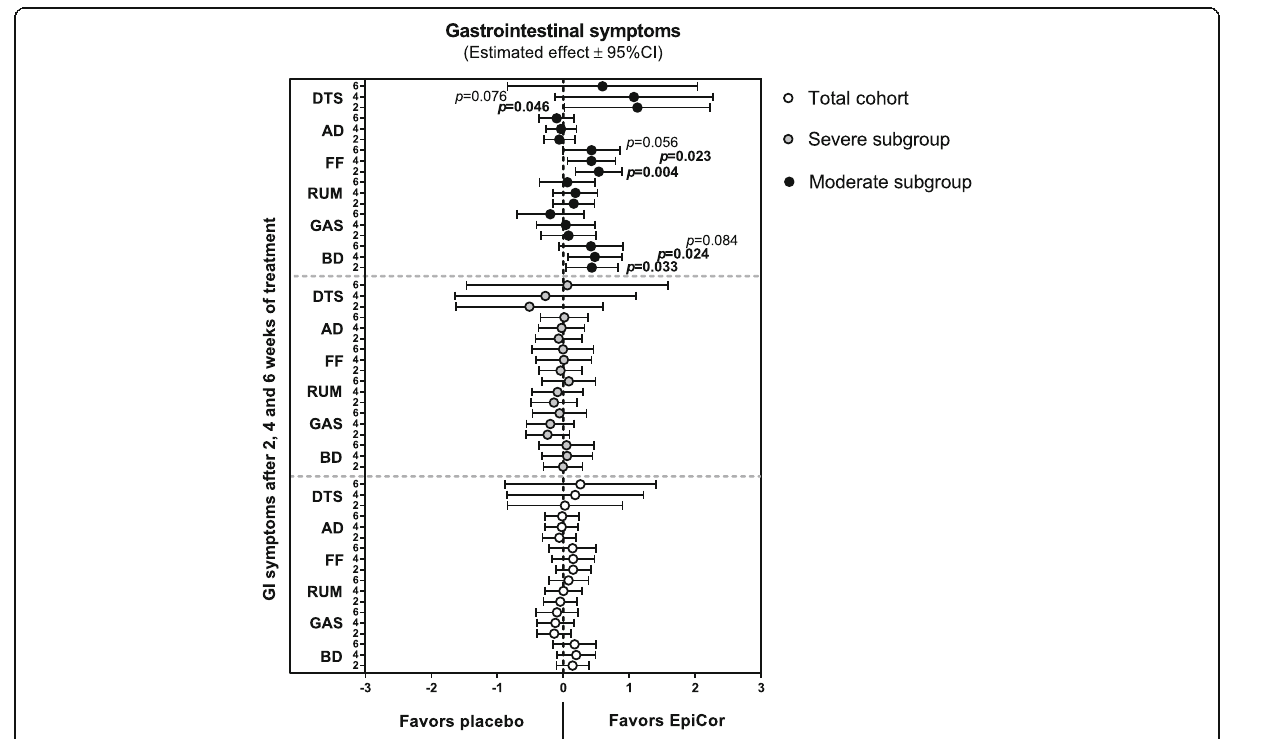
Fig. 3 Mean differences between EpiCor and placebo on gastrointestinal symptoms on the three cohorts. Legend: The enlisted gastrointestinal symptoms are BD (bloating/distension), GAS (passage of gas), RUM (GI rumbling), FF (feeling of fullness) and AD (abdominal discomfort). A daily total score (DTS) calculated as the sum of all items recorded each day is also shown. A linear mixed model analysis that takes into account the differences between groups at baseline was used ( p -values <0.05 are depicted in bold text; p -values <0.1 are depicted in regular